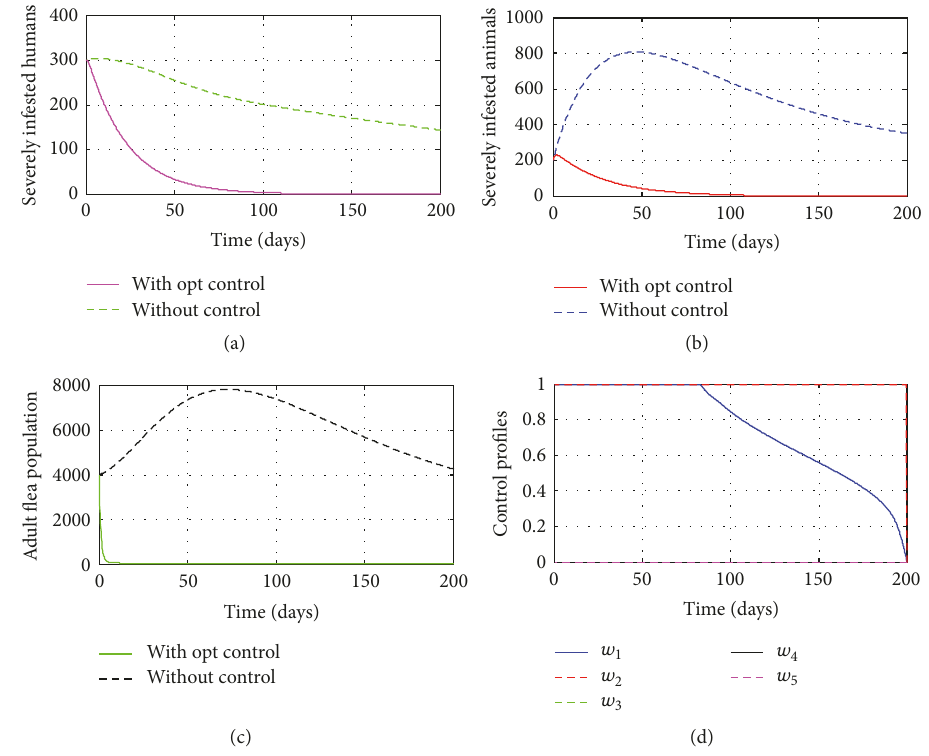
Figure 6: Optimal solutions for model variables 𝐼 𝐻ℎ , 𝐼 𝐴ℎ , 𝐹 𝐸 and the control profiles for 𝑤 1 , 𝑤 2 , 𝑤 3 , 𝑤 4 , 𝑤 5 with (𝑤 1 , 𝑤 2 ̸= 0)